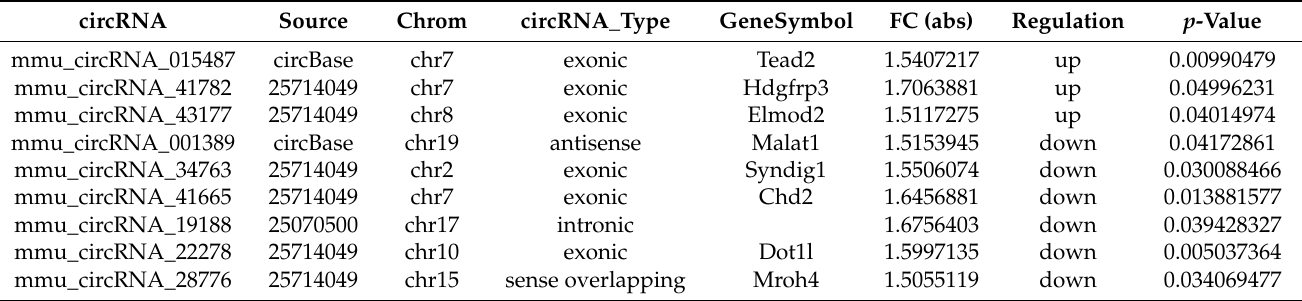
Figure 1. Changes in circRNA expressions in diabetic-derived neutrophils. ( A ) Scatter plot was used for assessing the circRNA expression variation between two samples or two groups of samples. The X- and Y-axes are the normalized signal values of the samples (log2 scaled). The green lines indicate fold change. CircRNAs above the top green line and below the bottom green line are circRNAs with more than 1.5-fold change between the two compared samples. ( B ) Volcano plots were used for visualizing differential expression between two different conditions. The vertical lines correspond to 1.5-fold increase and decrease, respectively, and the horizontal line represents a p -value of 0.05. The red points represent the differentially expressed circRNAs with statistical significance. Table 2. Differentially expressed circRNAs.